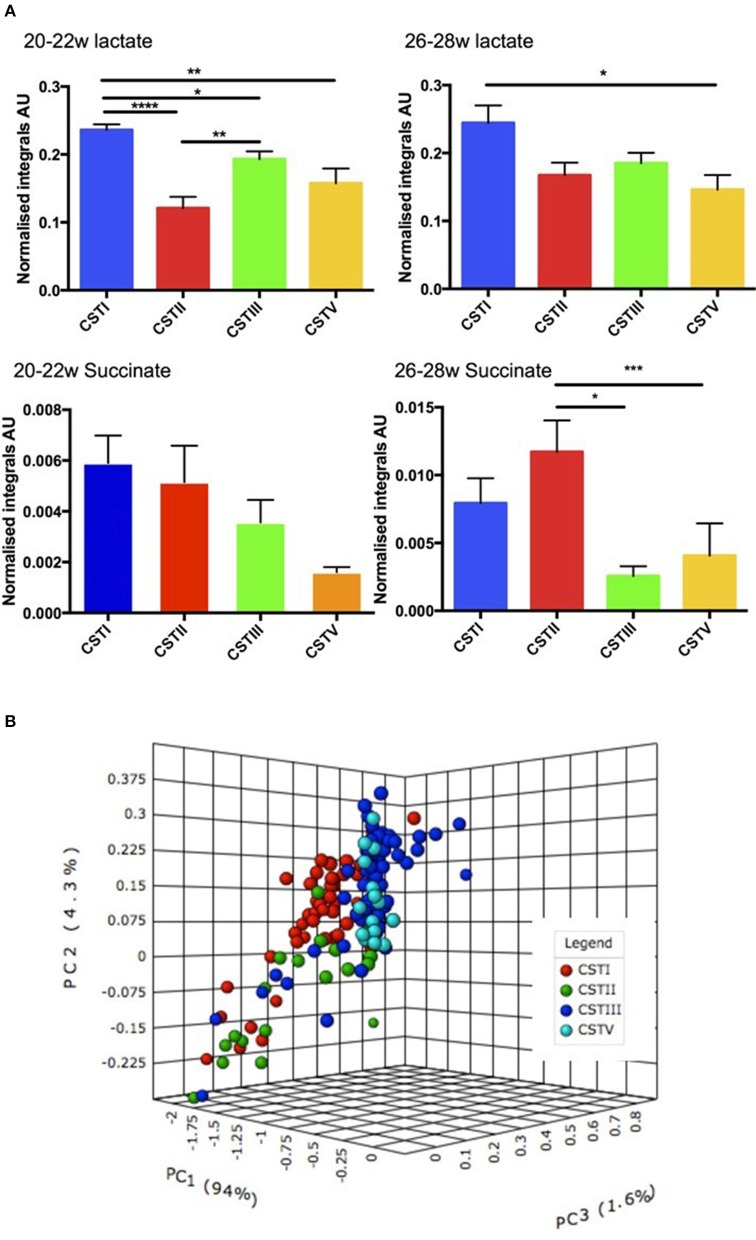
(A) Normalized metabolite data for lactate (upper) and succinate (lower) at 26–28 weeks and 20–22 weeks (AU, arbitrary units, *P < 0.05, **P < 0.01, ***P < 0.001, ****P < 0.0001). (B) PCoA 3D plot of CST with respect to metabolite levels generated using Metaboanalyst software.